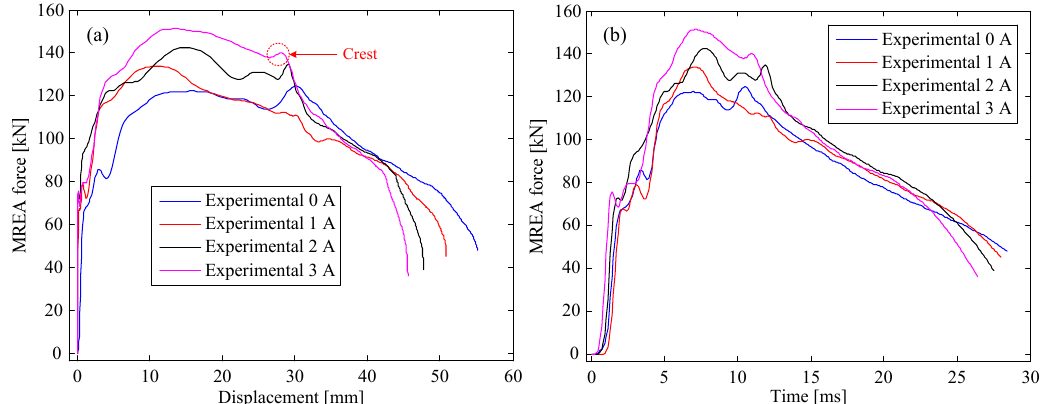
Molecules 2021 , 26 , x FOR PEER REVIEW Figure 4. MREA performances at a drop height of 0.7 m: ( a ) force vs. displacement and ( b ) time history of the force.